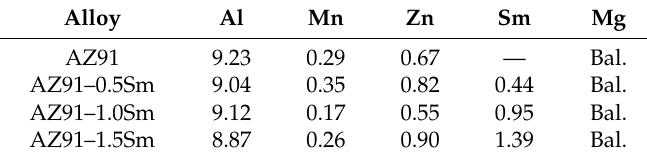
Table 1. Composition (wt %) of AZ91–xSm magnesium alloys treated with ultrasonic vibration.